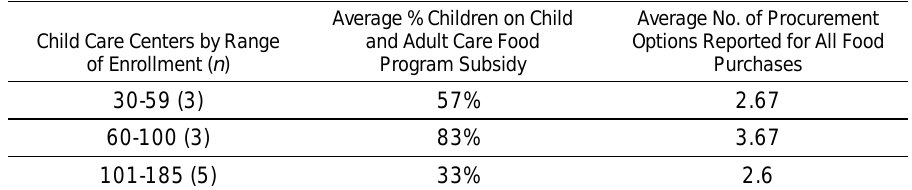
Table 1. Childcare Research Participants and Identifiers of the Child Population for Centers